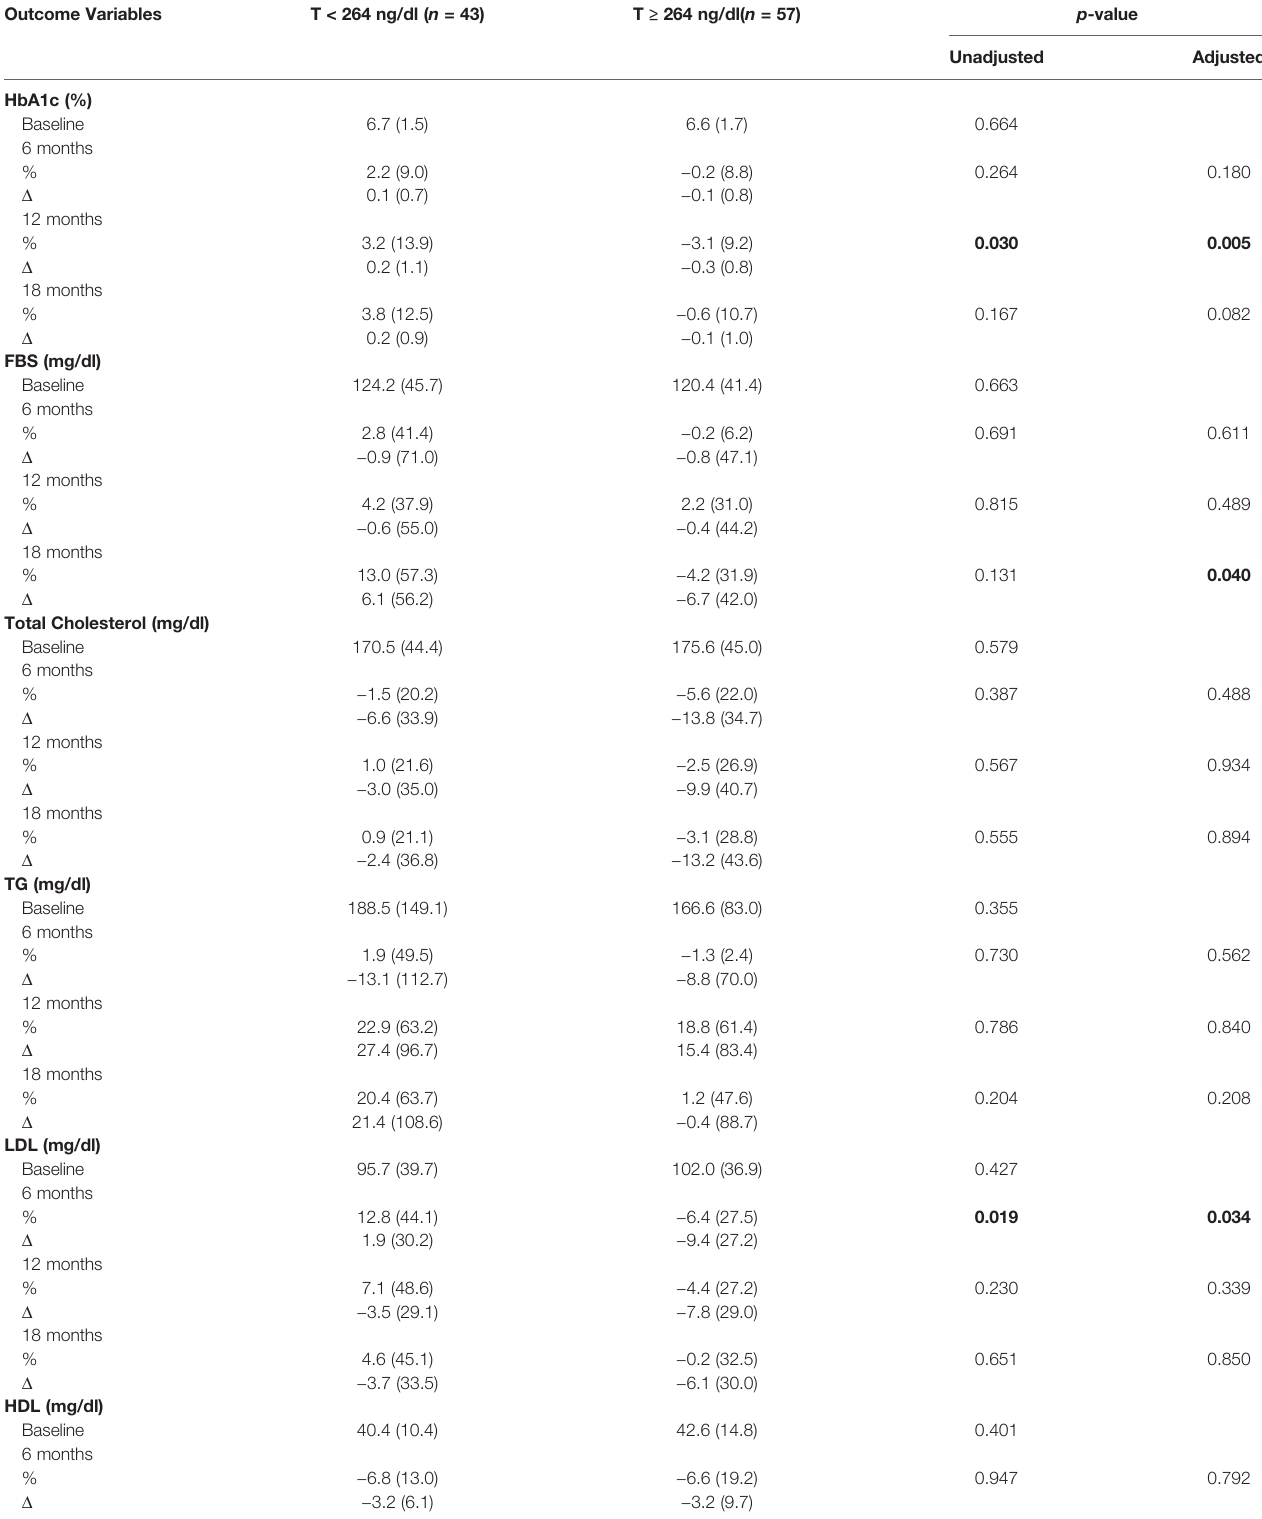
TABLE 3 | Changes in metabolic pro fi le and adipokines with testosterone therapy from baseline to 18 months between the two groups. Outcome